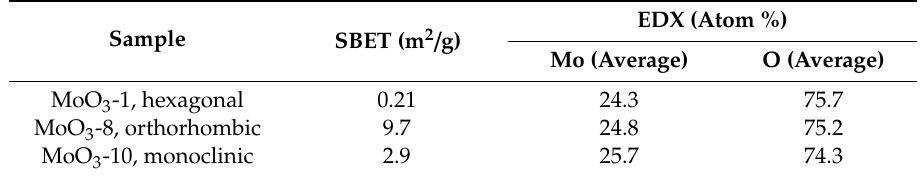
Table 2. The specific surface area (SBET) and EDX results of the di ff erent MoO 3 phases, MoO 3 -1: 90 ◦ C,